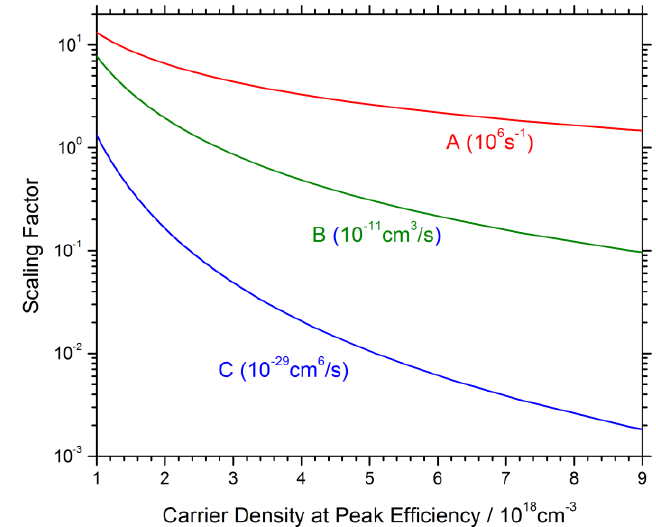
Figure 6. Illustration of recombination parameter sensitivity to the quantum well carrier density at peak efficiency. Each vertical combination of the recombination coefficients A, B, and C results in identical efficiency vs. current characteristics (the units are different as shown in parentheses) [42].